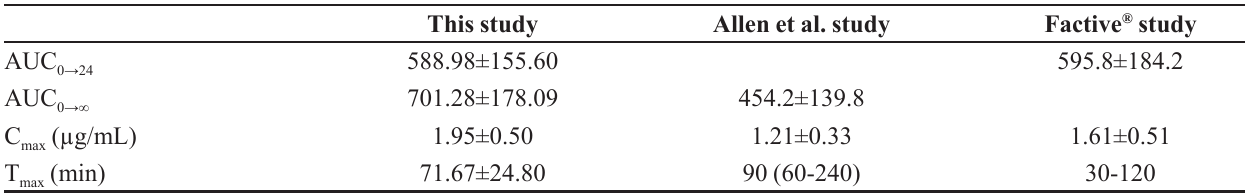
TABLE V- Comparison of pharmacokinetic parameters with other studies This study Allen et al. study Factive ®